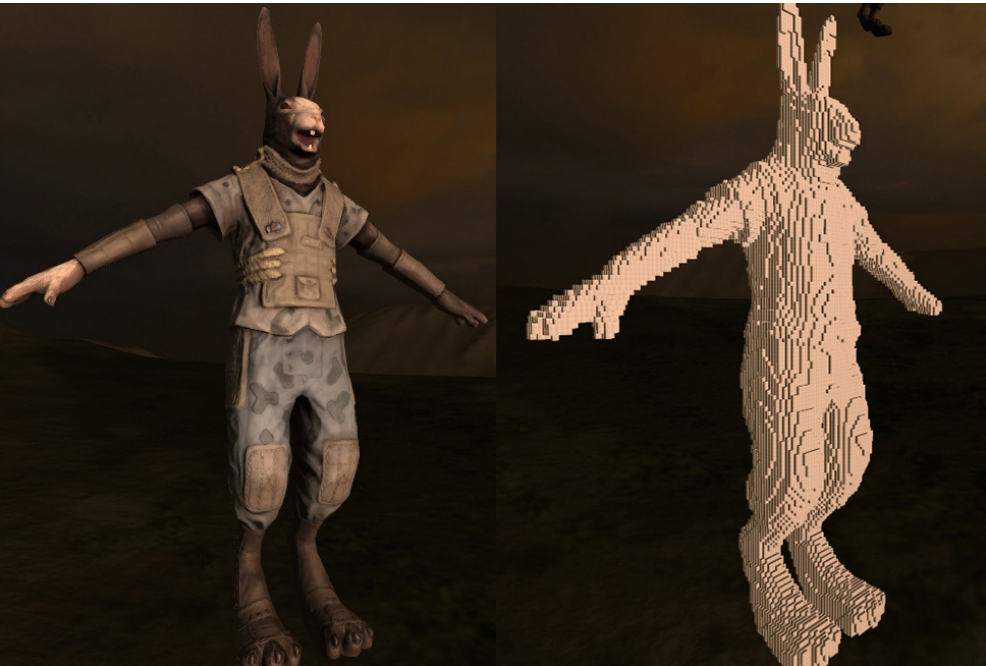
Fig. 9 Voxelization. Immagine da http://cdn.wolfire.com/blog/